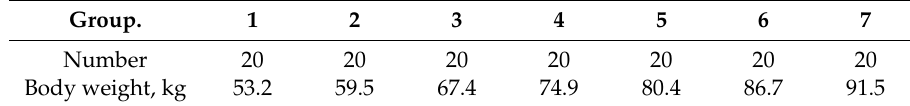
Table 1. Information of Liangshan pigs being